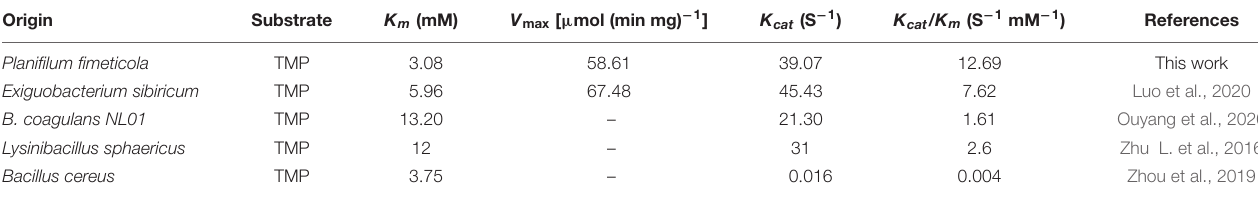
TABLE 2 | Comparison of Pf LeuDH with other reported